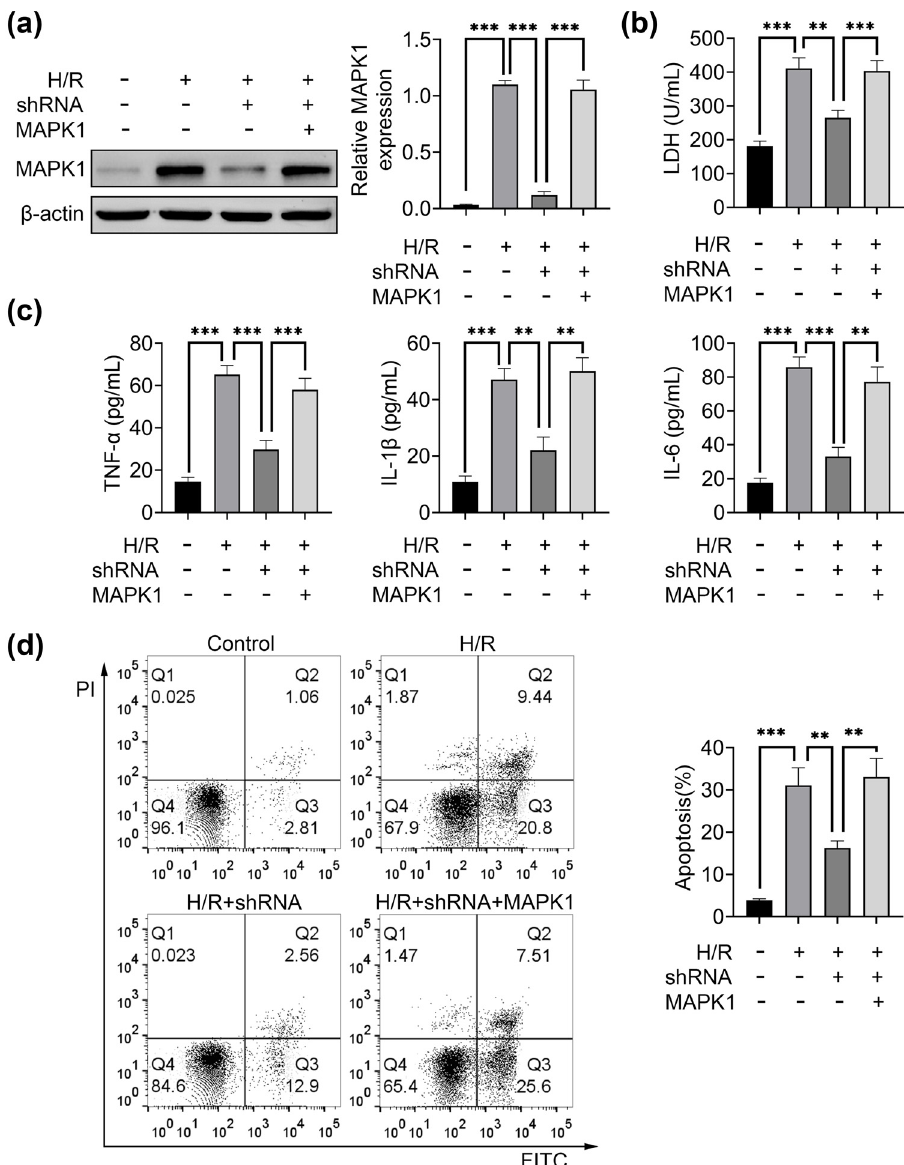
Figure 5: HAGLR was involved in regulating in fl ammation and cell apoptosis induced by H/R. ( a ) Western blotting was used to assess the relative protein expression of MAPK1 in H9C2 cells treated by H/R, knockdown of HAGLR ( shRNA ) and overexpression of MAPK1 ( MAPK1 ) . *** p < 0.001. Data were expressed as mean ± SD of three independent experiments. ( b ) The LDH level in the culture medium with H9C2 cells treated by H/R, shRNA and MAPK1. ** p < 0.01 and *** p < 0.001. Data were ex p ressed as mean ± SD of three independent experiments. ( c ) ELISA was used to assess the levels of TNF - α , IL - 1 β and IL - 6 of H9C2 cells treated by H/R, shRNA and MAPK1. ** p < 0.01 and *** p < 0.001. Data were expressed as mean ± SD of three independent experiments. ( d ) Flow cytometry was used to detect the cell apoptosis ratio of H9C2 cells treated by H/R, shRNA and MAPK1. ** p < 0.01 and *** p < 0.001. Data were expressed as mean ± SD of three independent ex p